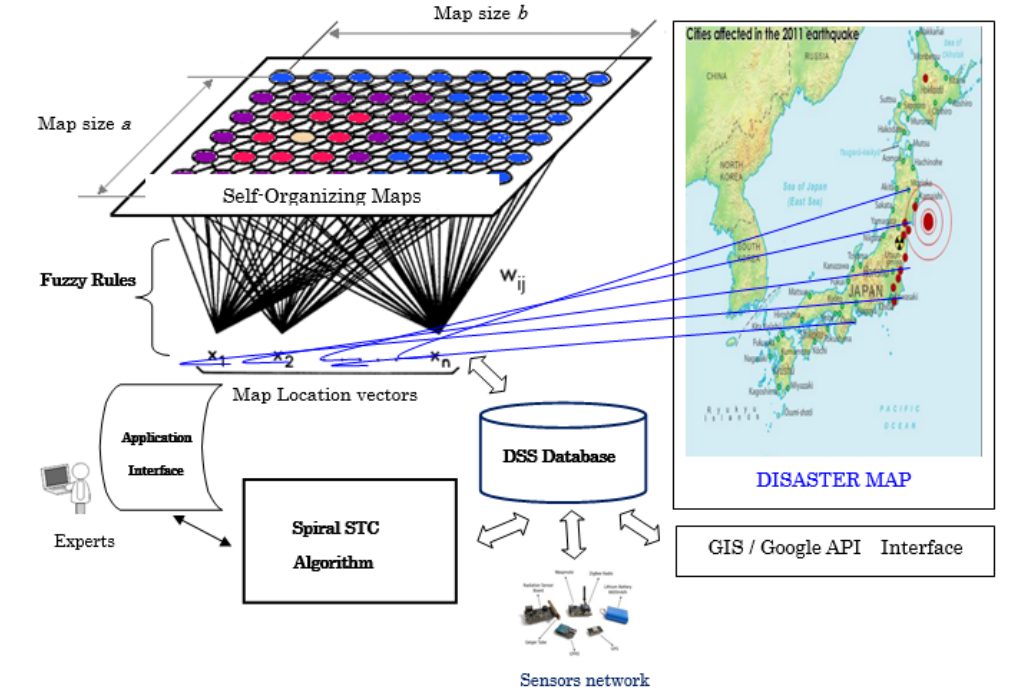
Figure 3. The proposed system showing pre emergency, an actual emergency, and post emergency